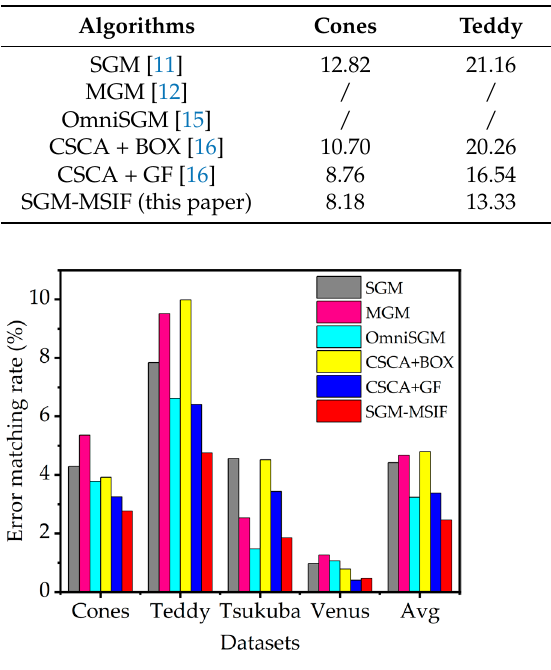
Figure 7. EMRs in Non-occ regions.